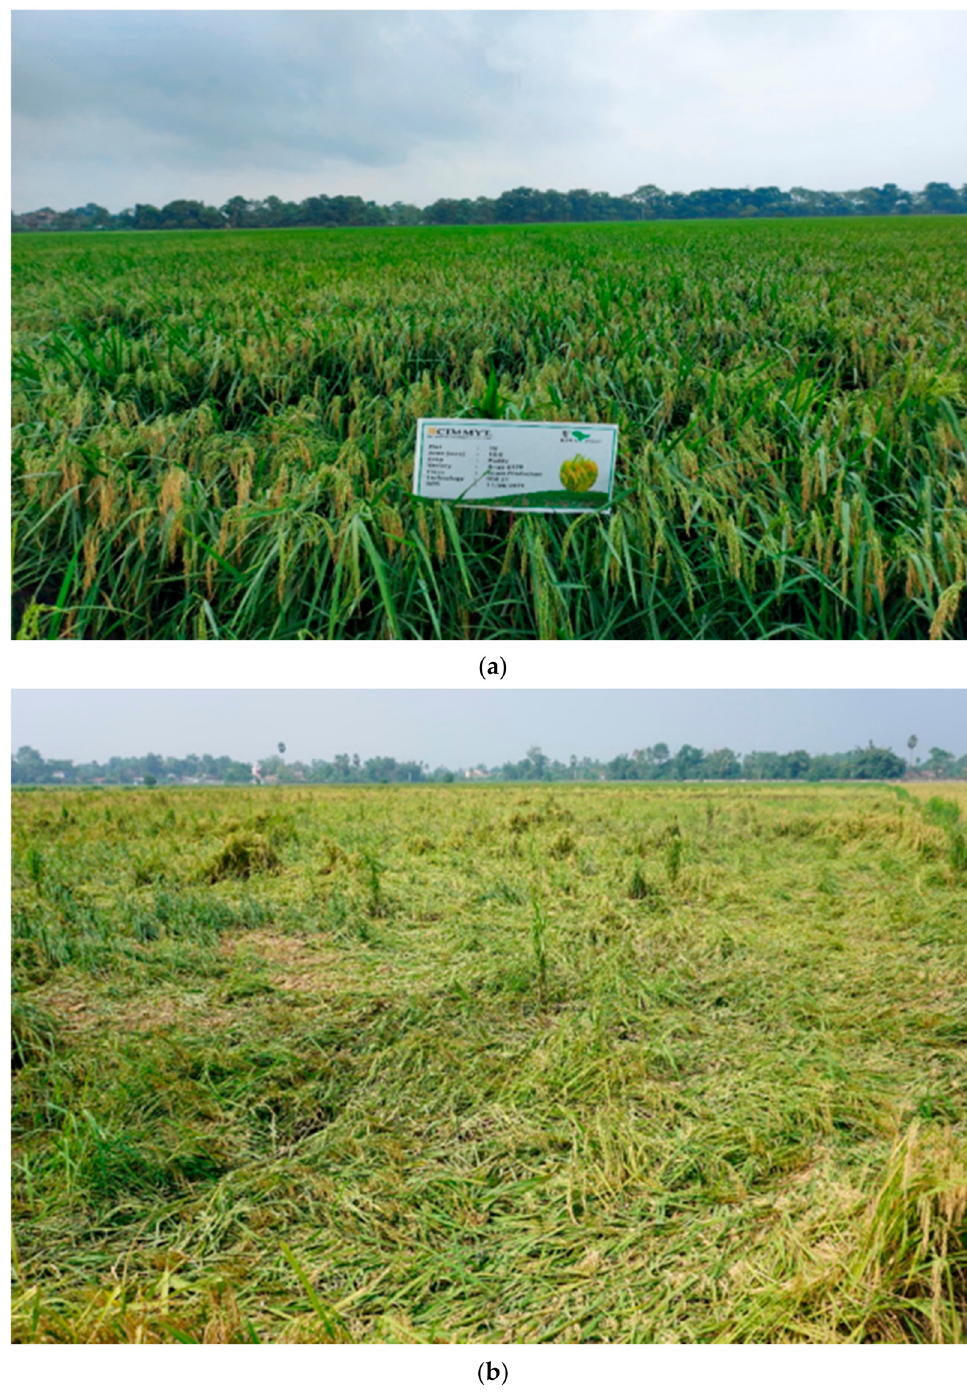
Figure 8. ( a ) Effect of adverse climatic conditions on the direct seeded rice crop. ( b ) Effect of adverse climatic conditions on the mechanically transplanted rice